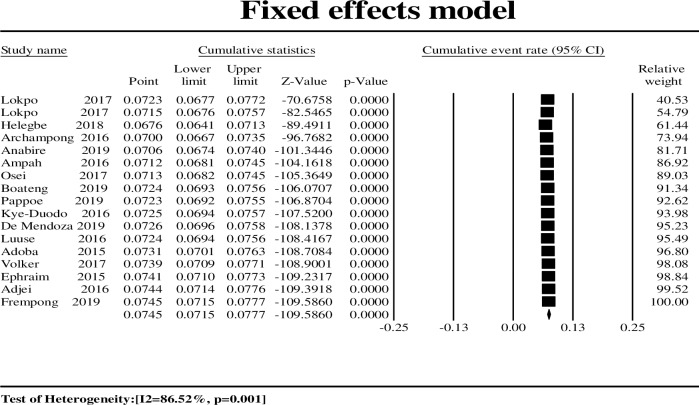
Cumulative forest plot for the included studies (fixed effects model) in the adult-only population.